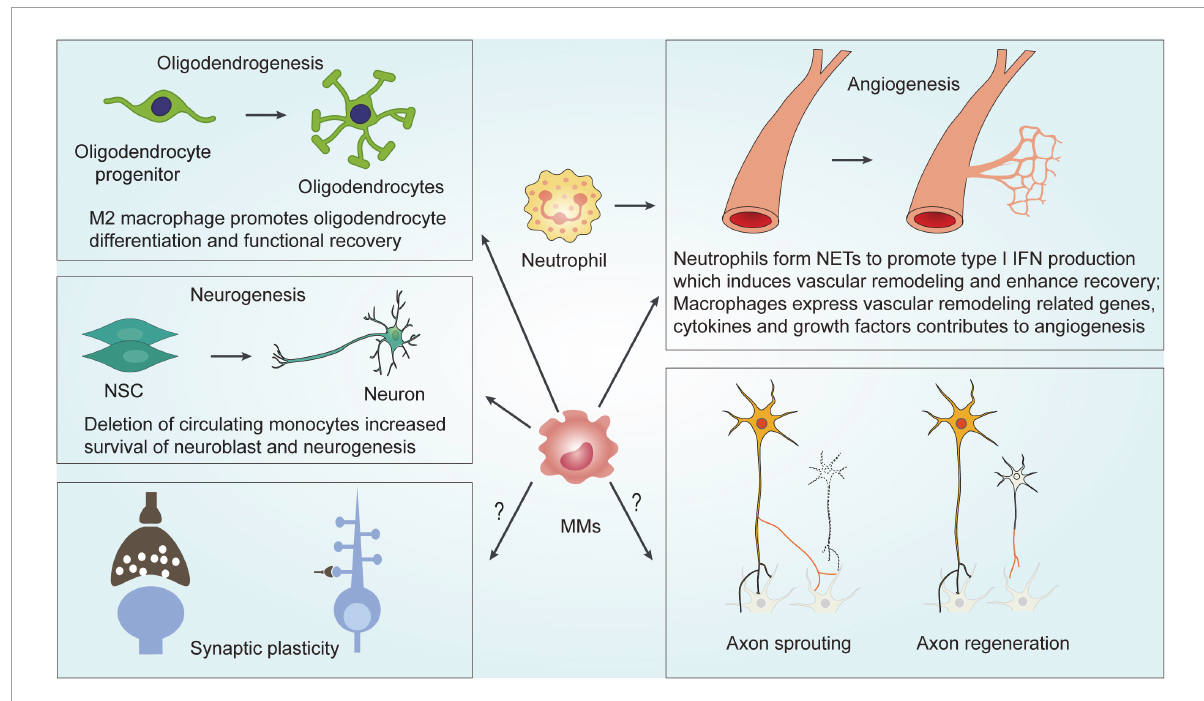
FIGURE2 Mechanisms underlying MMs and neutrophils-mediated effects on functional recovery after ischemic stroke. MMs regulates functional recovery by modulating neurogenesis, angiogenesis and oligodendrogenesis. NETs formation of neutrophils induces vascular remodeling and angiogenesis to enhance functional recovery. MMs, Monocytes and macrophage; NSC, neural stem cell; NET, neutrophil extracellular traps; IFN,